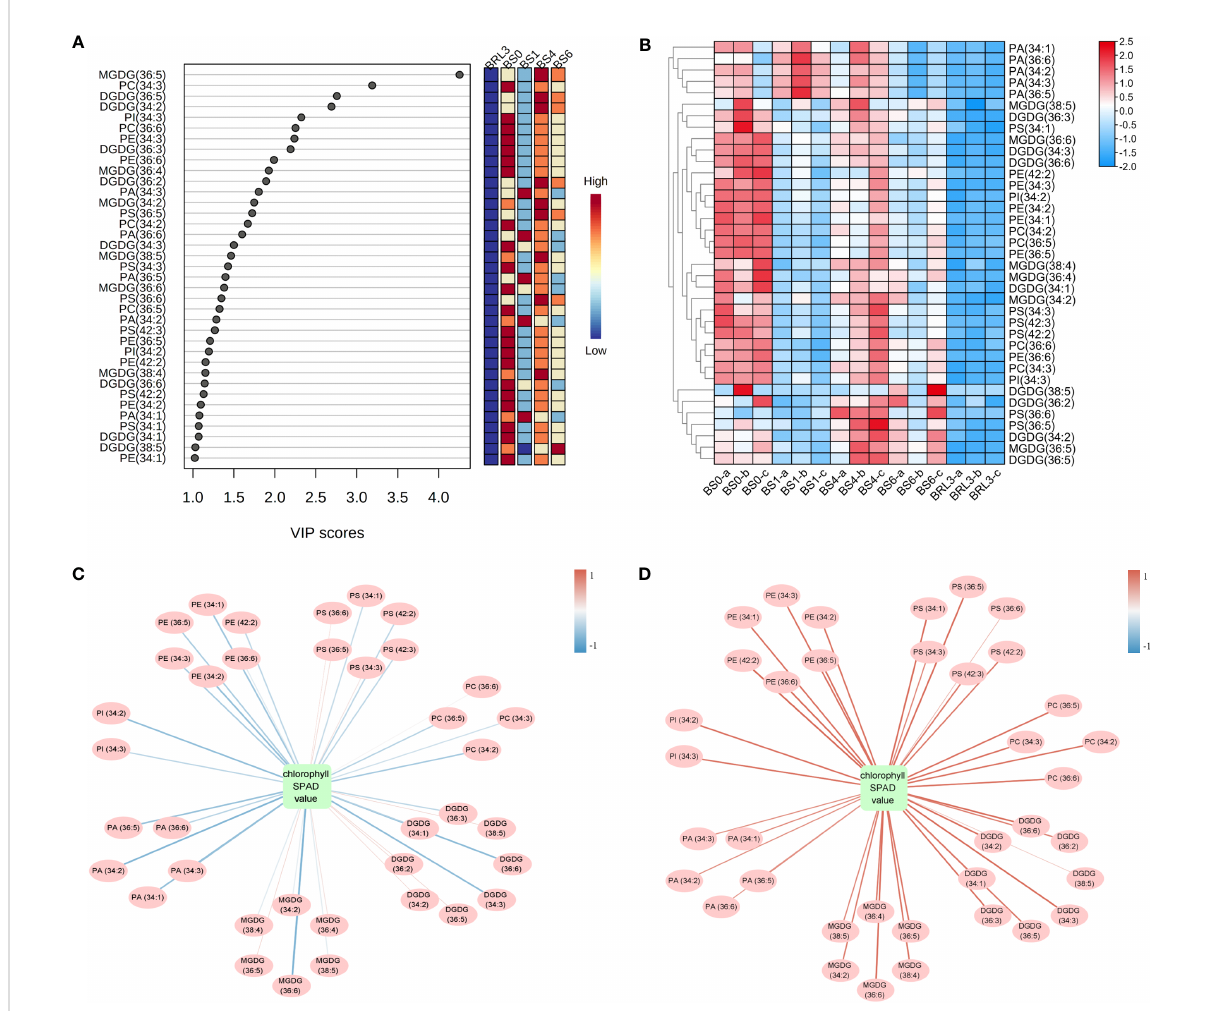
FIGURE 6 Statistical analysis of the differential lipid molecules. (A) Scores (VIP ≥ 1.0) of lipid species by PLS-DA in BJG. (B) Heatmap of the differential lipid changes in BJG after shading and light recovery treatments. Each colored cell on the map corresponds to the content of different lipid species. Red color indicates high, and blue color indicates low. (C) Correlation network between differential lipid molecules and chlorophyll SPAD value in BJG after shading. (D) Correlation network between differential lipid molecules and chlorophyll SPAD values in BS0 and BRL3. The red line indicates a positive correlation, the blue line indicates a negative correlation, and the darker the color is, the stronger the